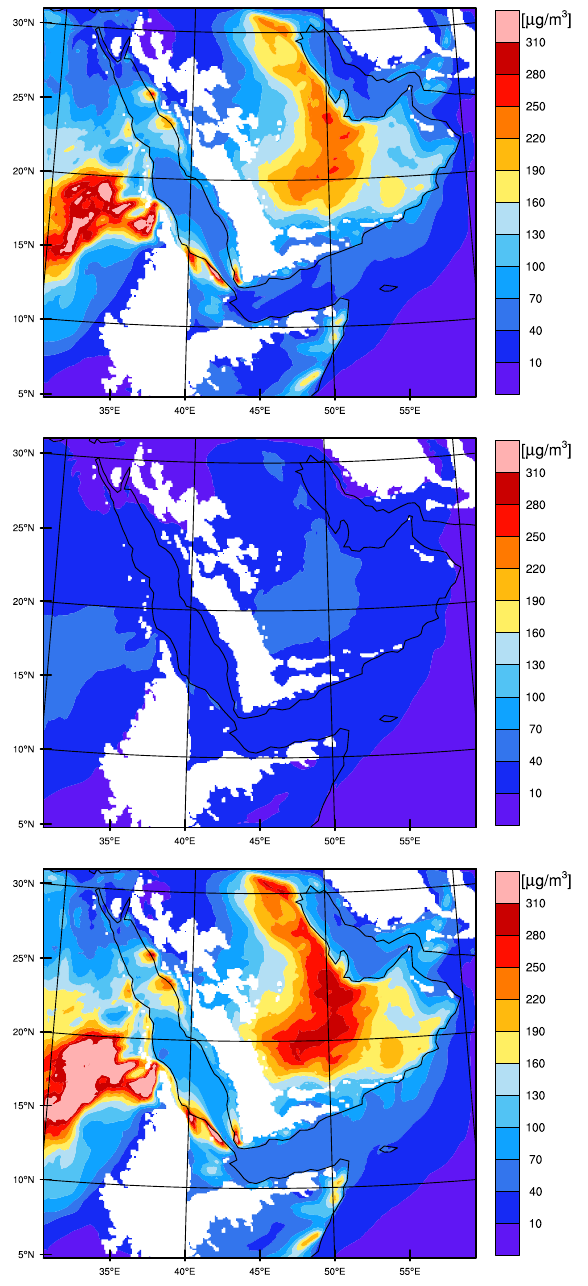
Fig. 4. Daytime (07:00–14:00UTC) mean spatial distributions of the dust mass concentration [µgm − 3 ] in the lower atmosphere aver- aged over the simulation period: coarse mode (top panel), accumu- lation mode (middle panel), and total concentrations (bottom panel).